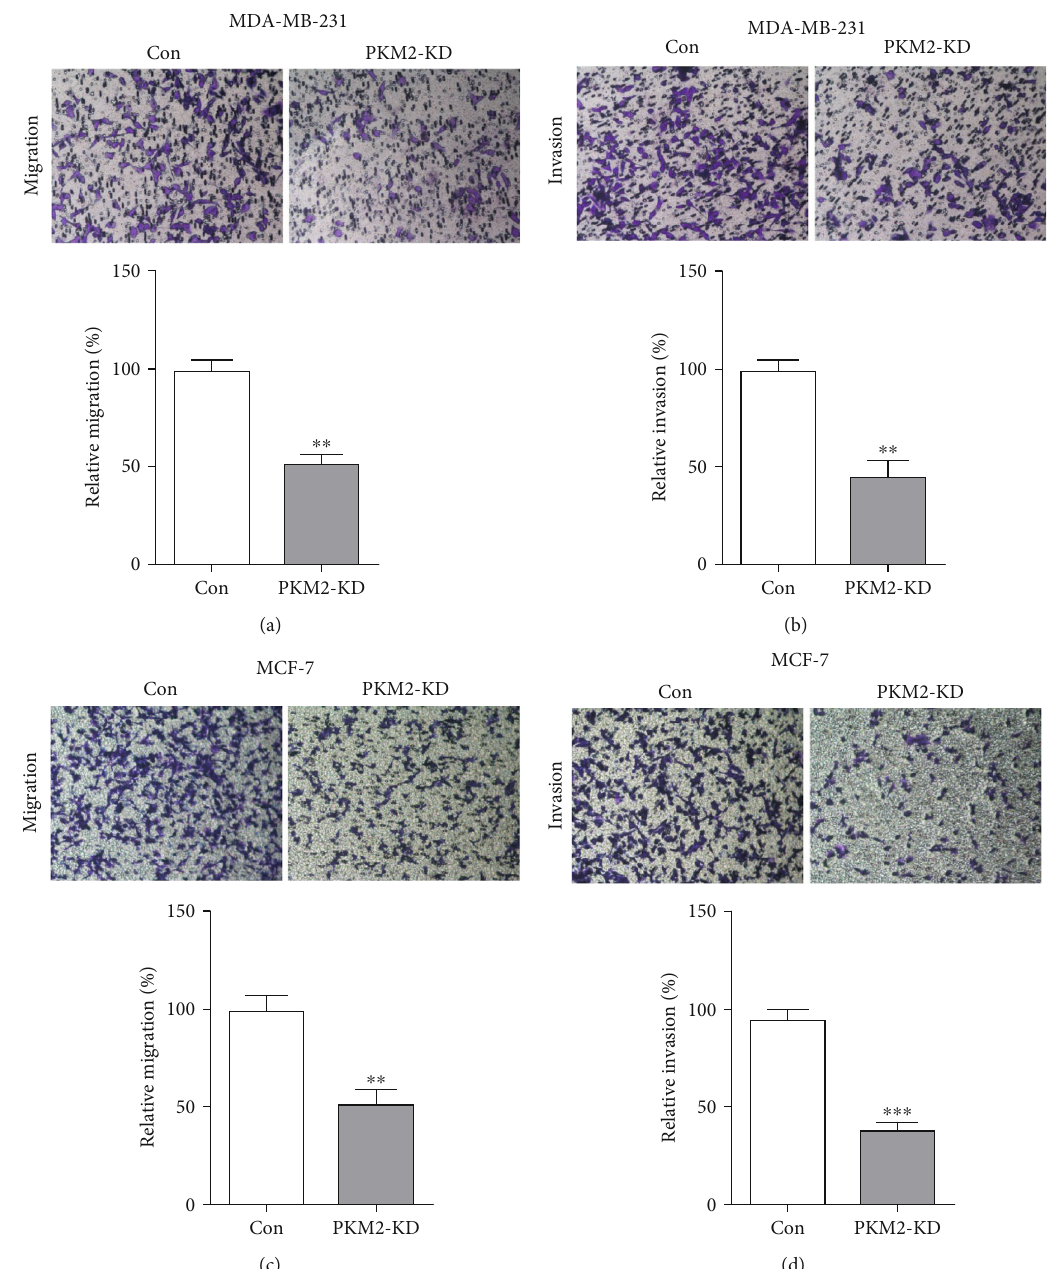
Figure 4: PKM2 is required for breast cancer cell migration and invasion. Cell migration (a) and invasion (b) of MDA-MB-231 cells after PKM2 knockdown was determined by transwell assay. Cell migration (c) and invasion (d) of MCF-7 cells after PKM2 knockdown was determined by transwell assay. Representative images from the migration and invasion of control and PKM2-KD cells of MDA-MB-231 and MCF-7 cells (top panel). Cell migration and invasion are expressed as a percentage of control (bottom panel). Cells were counted for at least fi ve random microscope fi elds. Results are shown as mean ± SD from three independent experiments. ( ∗∗∗ P < 0 : 001 . ∗∗ P < 0 : 01